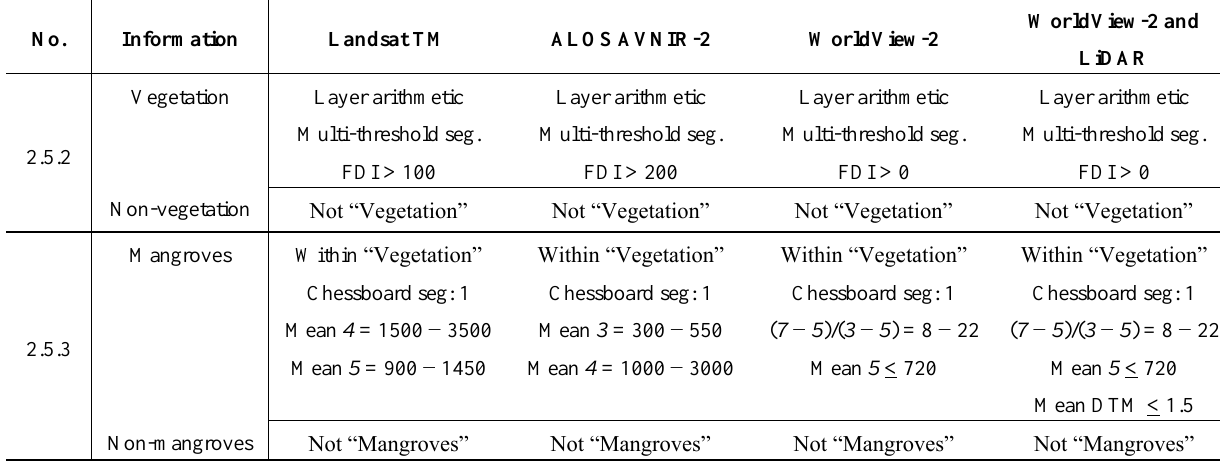
Figure 4. Image objects hierarchy for multi-scale mangrove mapping, objects relationships, and the levels of information at each hierarchy level. Table 3. Summary of the membership rules used in the multi-scale mangrove classification rule sets for Moreton Bay mangroves. The numbers in the table correspond to section numbers in the method section of this